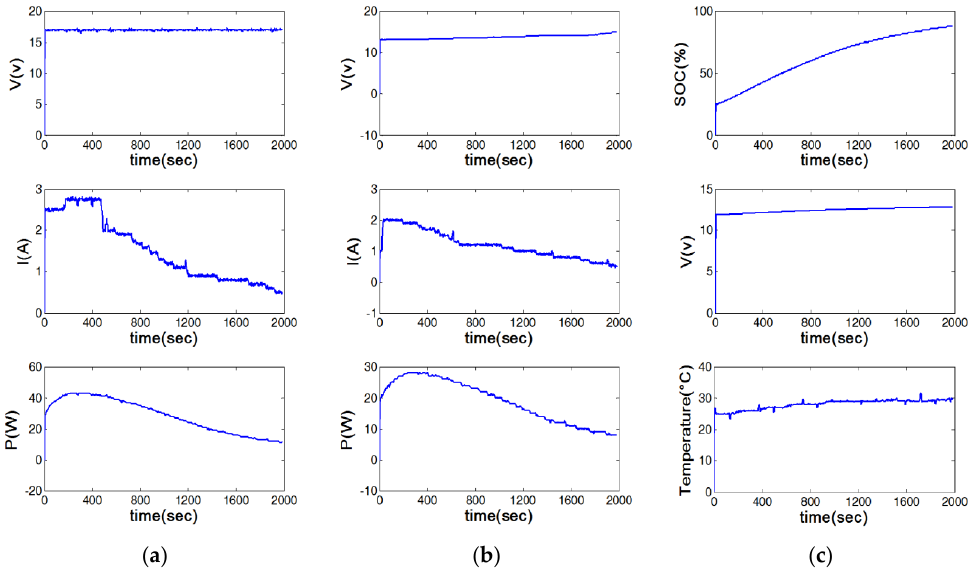
Figure 5. CV charging. ( a ) Power end voltage, current and power curves; ( b ) battery end charging voltage, current and power curves; ( c ) SOC (%), actual voltage and temperature (°C) curves inside battery.